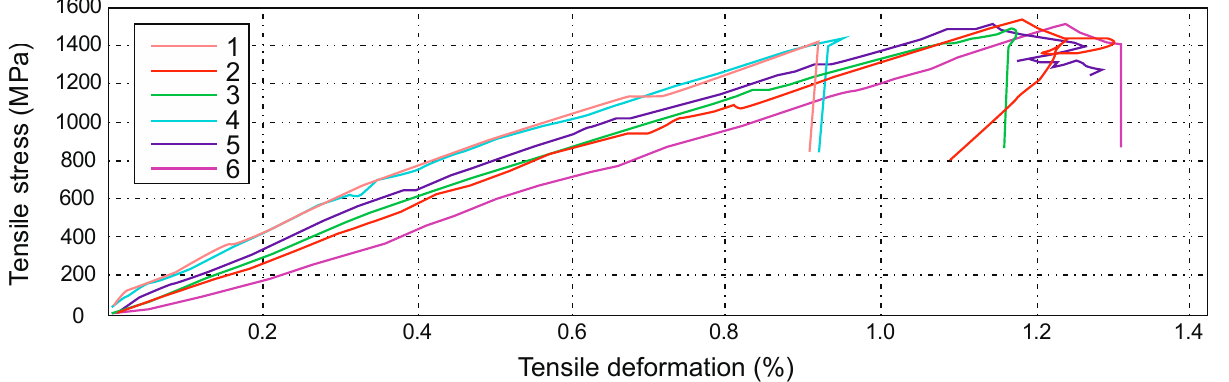
Figure 22. Graph showing the tensile stress and deformation of a laminate reinforced with IMS65 modular fabric, 0/90° configuration.